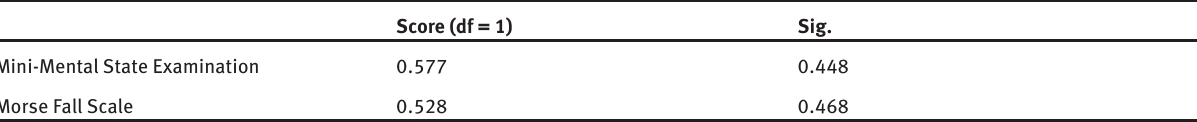
R2 = 0.302 (Cox & Snell R Square). Model X2 (1) = 11.888, p < 0.01. Hosmer and Lemeshow X2 = 8.890, p = 0.352. Overall percentage correct = 81.8%